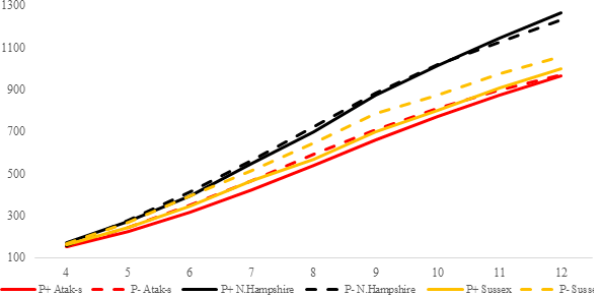
Figure 2. Trends of weekly average live weights for P + and P − groups by genotype in an ad libitum environment